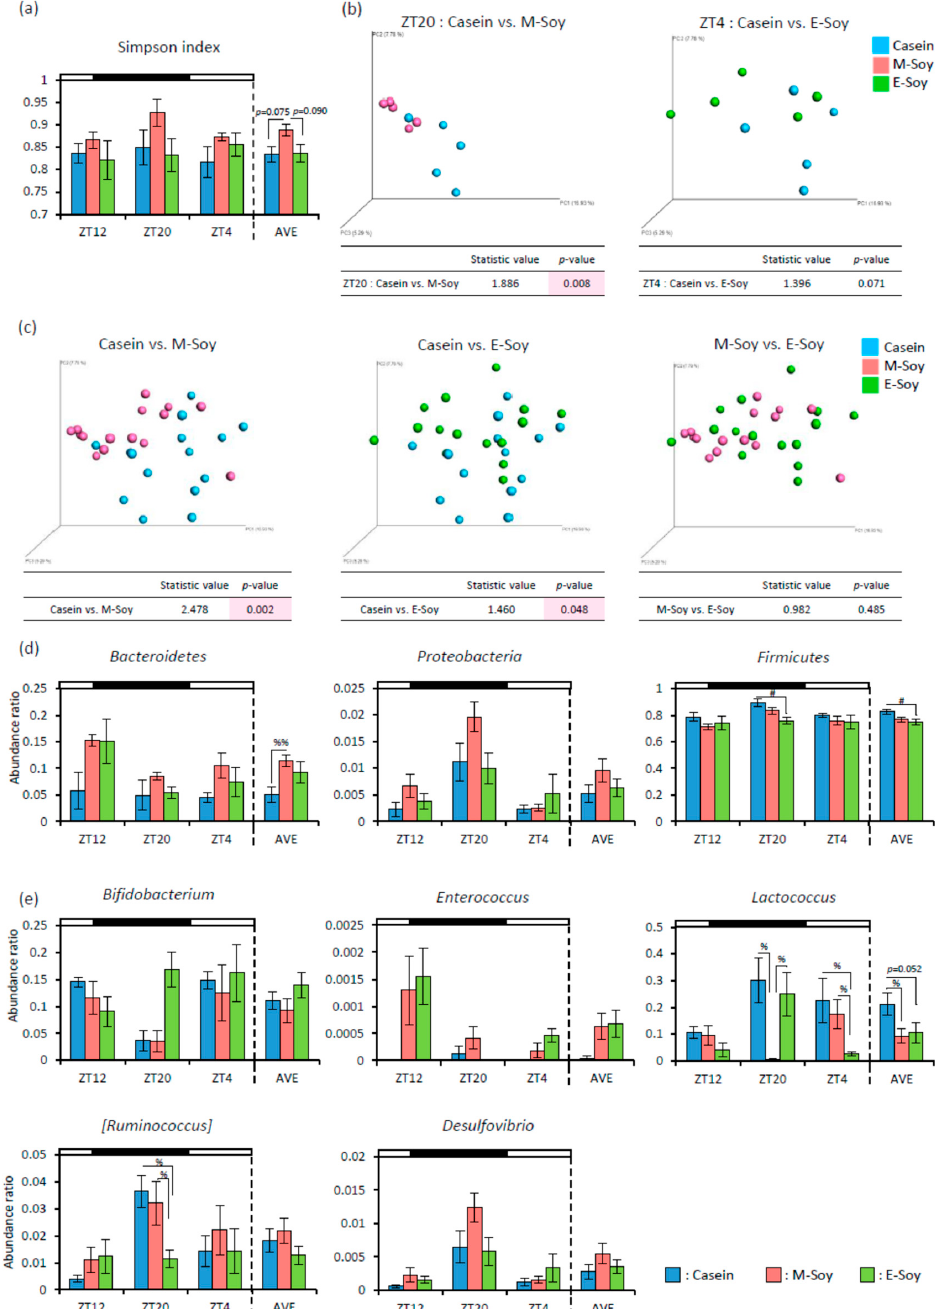
Figure 8. The effect of soy protein intake timing on microbiota. ( a ) Alpha-diversity about Simpson index (ZT12, ZT20, ZT4, and an average of three points) of mice that were kept in each feeding condition for two weeks. ( b ) Beta-diversity in comparison of Casein and M-Soy at ZT20, or Casein and E-Soy at ZT4, shortly after soy protein intake ( n = 5). ( c ) Beta-diversity in comparison of Casein and M-Soy, Casein and E-Soy, or M-Soy and E-Soy. The PCoA plots of unweighted UniFrac distance metrics obtained from sequencing the 16S rRNA gene in feces ( n = 15). ( d ) The relative abundance of microbes at the Phylum level, and ( e ) at the Genus level of mice that were kept in each feeding condition for two weeks. Data ( a , d , e ) are represented as mean ± SEM ( n = 5). # p < 0.05 evaluated using one-way ANOVA with Tukey’s post-hoc test. % p < 0.05, %% p < 0.01 the Kruskal-Wallis test with Dunn’s post-hoc test. The tables in ( b , c ) indicate the result using PERMANOVA.